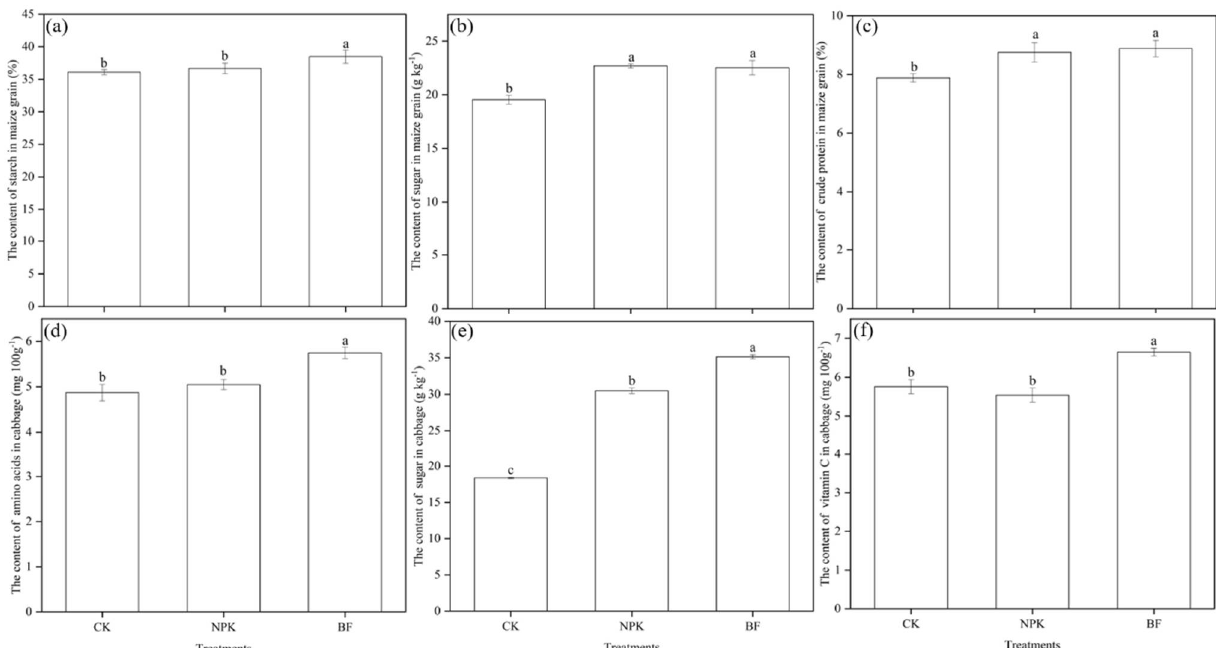
Figure 6. Quality of the maize and cabbage under different N treatments in 2020. ( a ), The content of starch in maize grain. ( b ), The sugar content in maize grain. ( c ), The content of crude protein in maize grain. ( d ), The amino acid content in cabbage. ( e ), The sugar content in cabbage. ( f ), The content of vitamin C in cabbage. The error bars show the standard deviations of the means (n = 3). Different lowercase letters indicate significant differences among treatments ( p < 0.05).